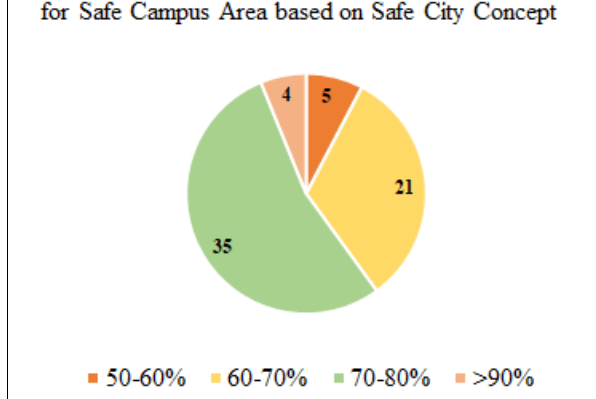
Figure 7. Percentage of building with Safety Level percentage in UTM